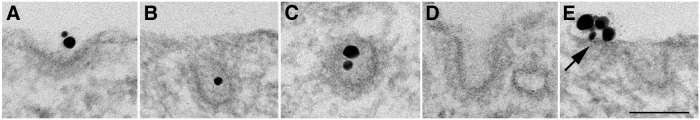
Endocytosis of NMDA receptors. A–C, Label for NR2B is sometimes located in clathrin-coated pits (A, B) and the lumens of coated vesicles (C). D, E, Many clathrin-coated pits are not labeled for NR2B. NR-labeled islands (E, arrow) may lie immediately adjacent to a coated pit, but are not endocytosed as an island. Scale bars, 0.1 µm.